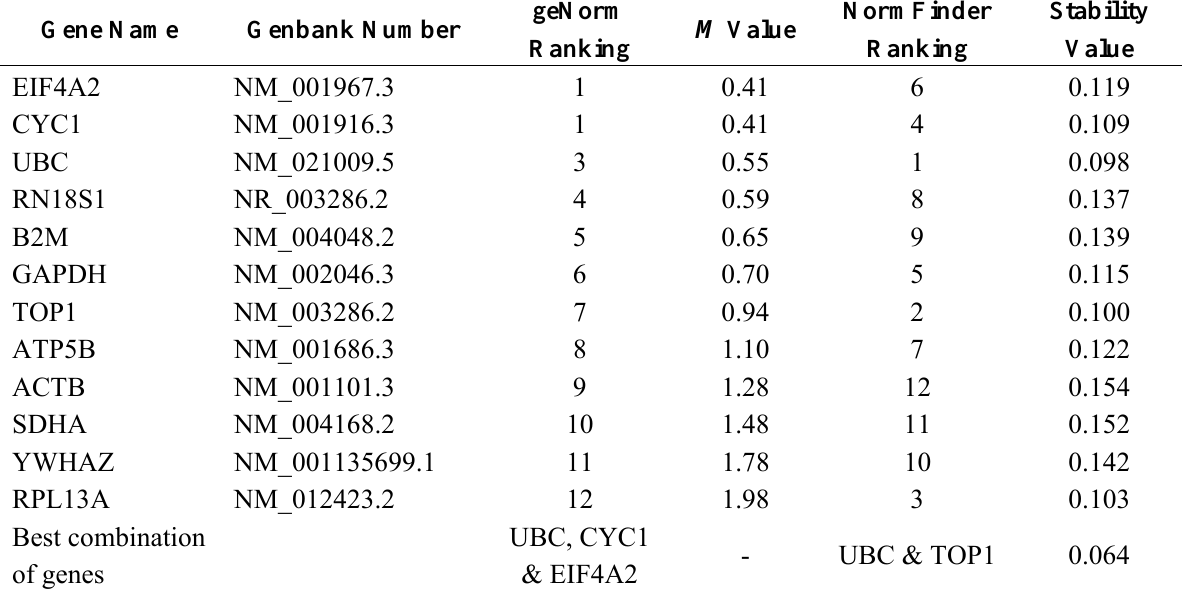
Table 1. Ranking of reference genes in fallopian tubes using the geNorm ( M value) and NormFinder (stability value) algorithms. Lower M or stability value indicates more stable expression and vice versa . Genes highlighted in bold were those ranking consistently in the top half of the table using both